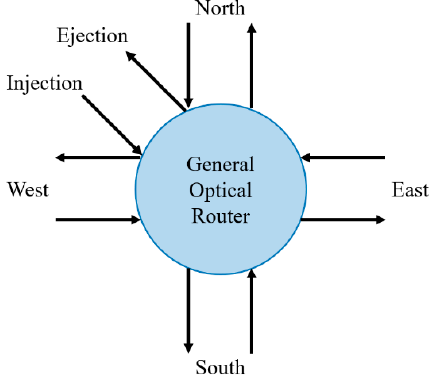
Figure 2. Semiconductor optical amplifier (SOA)-enabled HONoC architecture.